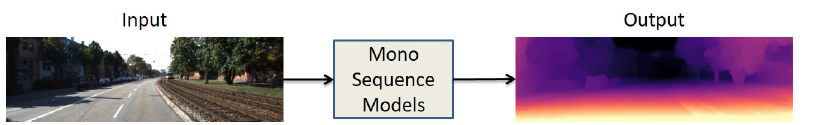
Figure 4. Data input/output structure of mono-sequence models. Single image input and single image